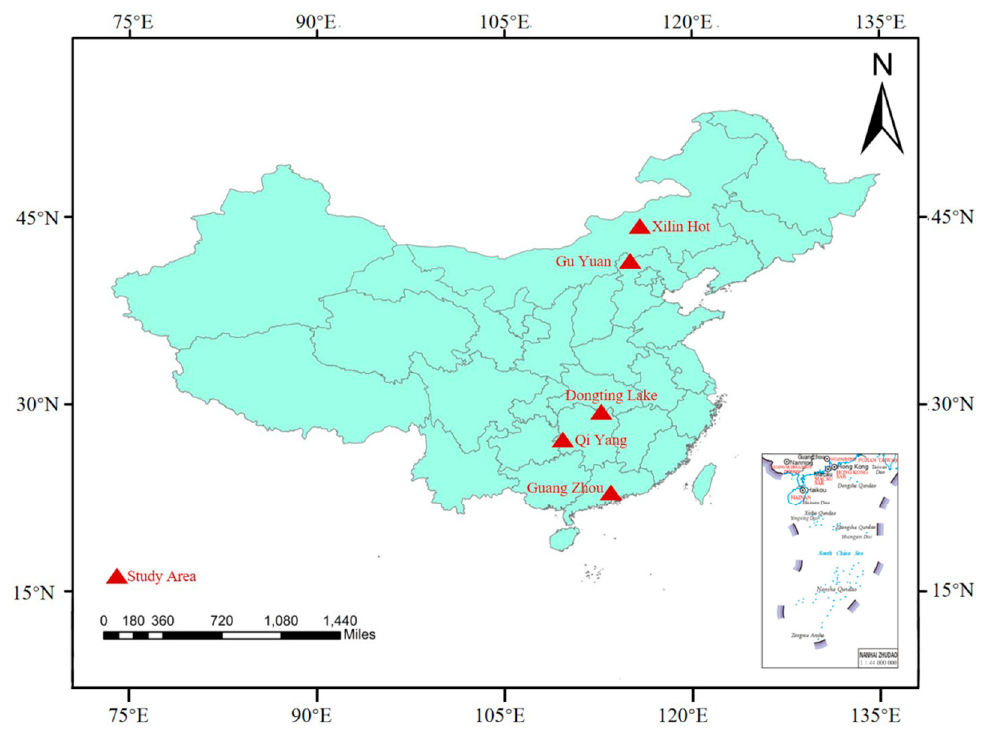
Figure 2. Five test sites for surface spectral reflectance measurement. The areas marked in red on the map are the test areas—Xilinhot, Guyuan, Dongting Lake, Qiyang, and Guangzhou—from top to bottom. Table 3. The central longitude and latitude, date, and synchronized DEM value and AOD of the